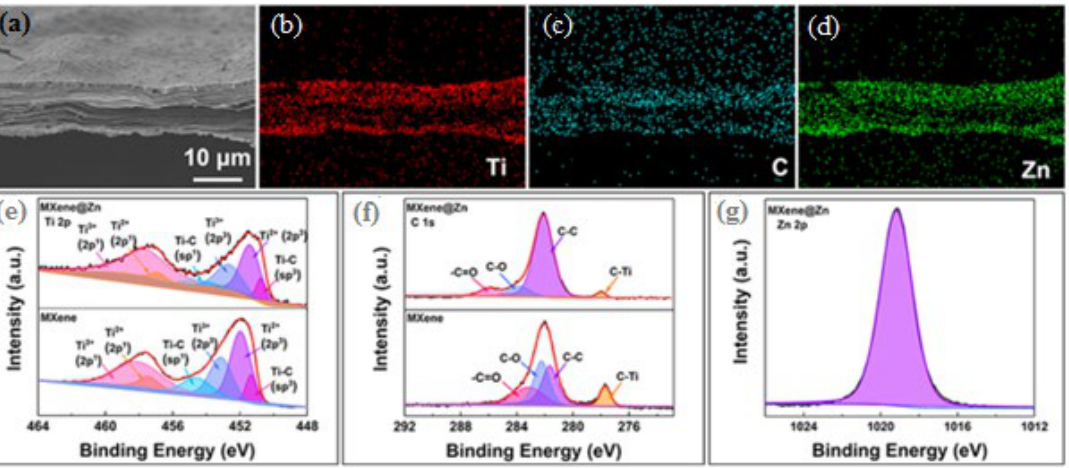
Figure 21. ( a ) Cross-sectional SEM image and ( b – d ) corresponding elemental distribution of Ti 3 C 2 T x MXene@Zn paper: ( b ) Ti ( c ) C, ( d ) Zn. High-resolution XPS spectra for ( e ) Ti 2p, ( f ) C 1s of Ti3C2Tx Mxene and Ti 3 C 2 T x Mxene@Zn, and ( g ) Zn 2p 3/2 of Ti 3 C 2 T x Mxene@Zn. Reprinted with